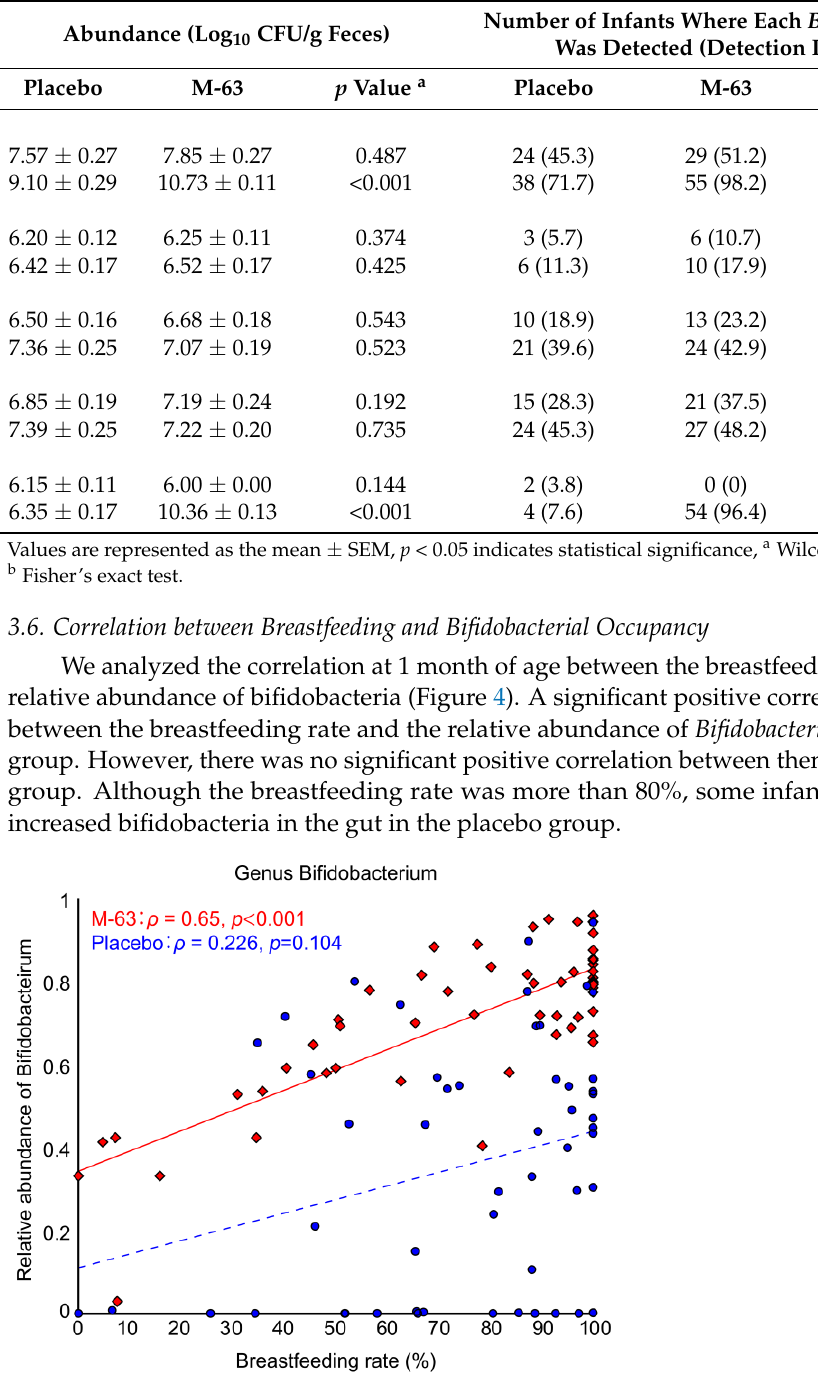
Table 4. pH, amount of short-chain fatty acid, IgA, and calprotectin in the stools. Placebo